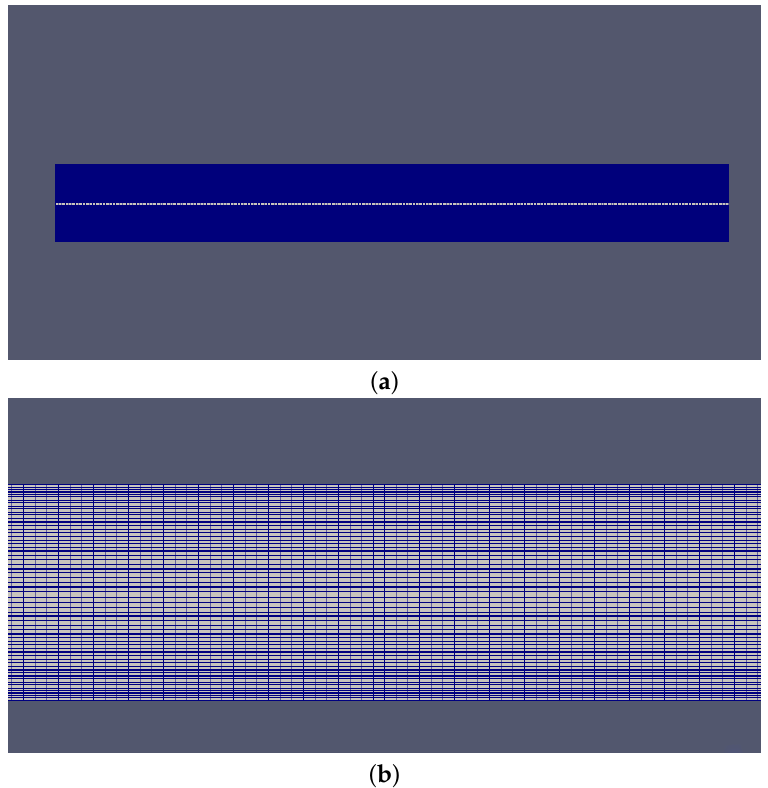
Figure 5. Mesh generation for two-phase flow pattern